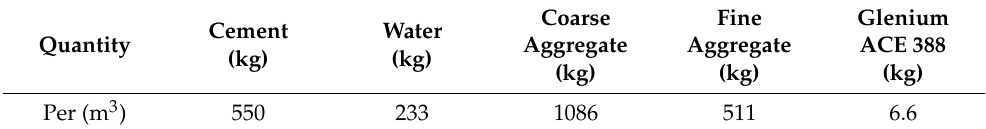
Table 1. The proportions of concrete materials.